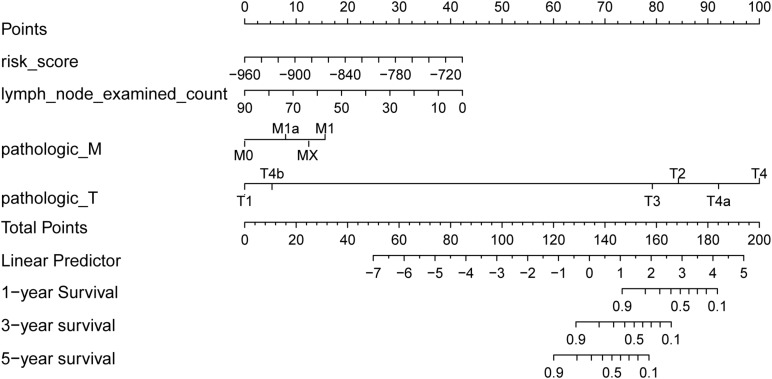
Survival rate predicted by nomograms. The factors used to construct the nomograms include risk score, lymph node examined count, pathologic M, and pathologic T. Total points are generated according to the values of these factors, corresponding to the survival probability of 1/3/5 years.